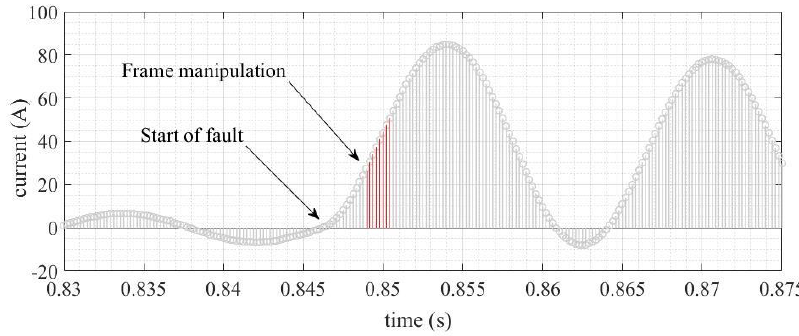
Figure 10. Instantly initiate faults and perform detailed package manipulations.